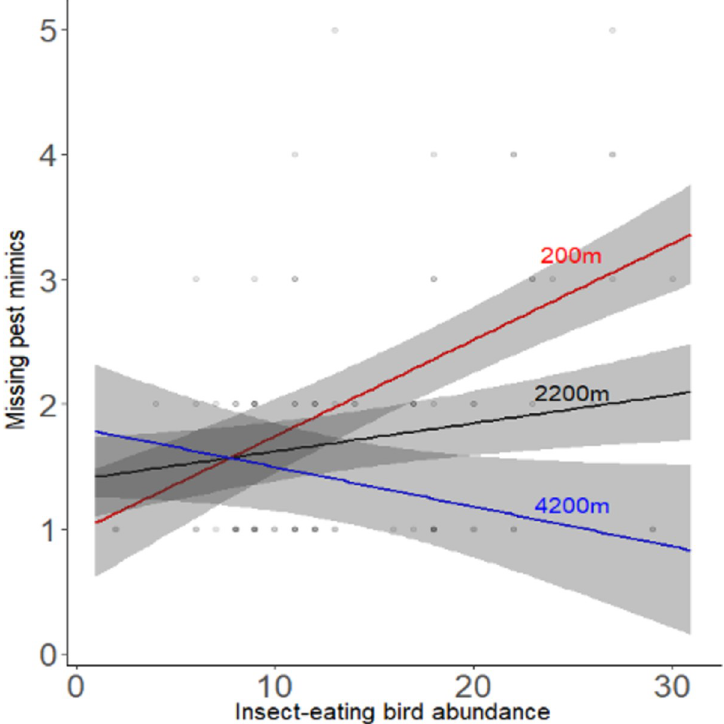
Fig 5. How the relationship between missing prey mimics and insect-eating bird abundance varies with distance from a forest fragment. We estimated the predicted values from model in Table 2 and plotted the predicted lines. Crop was set to A and the colour to brown, and we plotted three separate lines for close distance at ‘200m’, intermediate distance at ‘2200m’ and a far distance at ‘4200m’. These lines show how the gradient becomes less steep further away from the forest